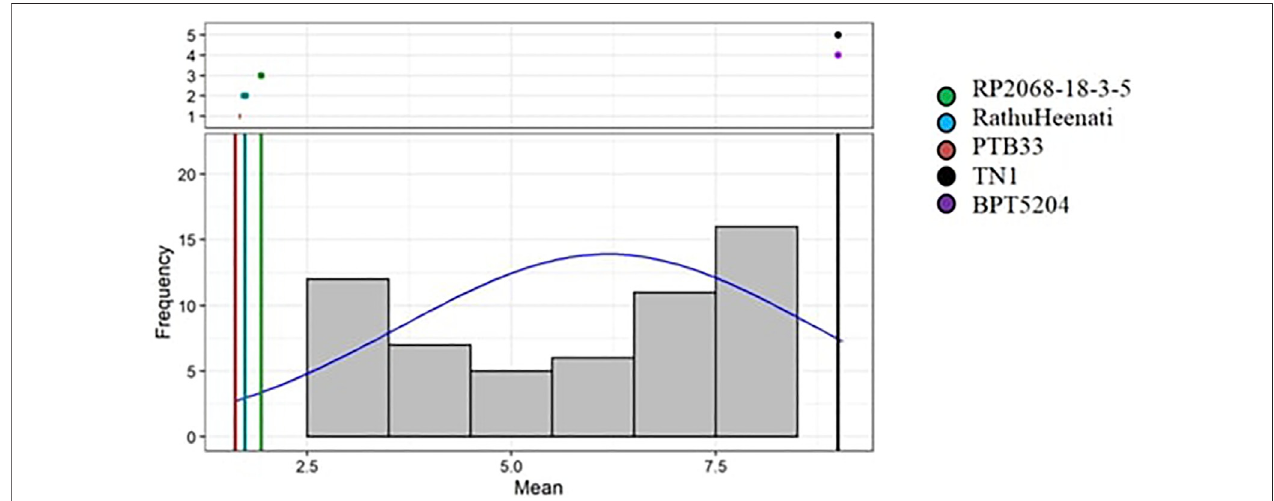
FIGURE 2 | Frequency distribution of adjusted mean BPH scoring values of the rice genotypes.